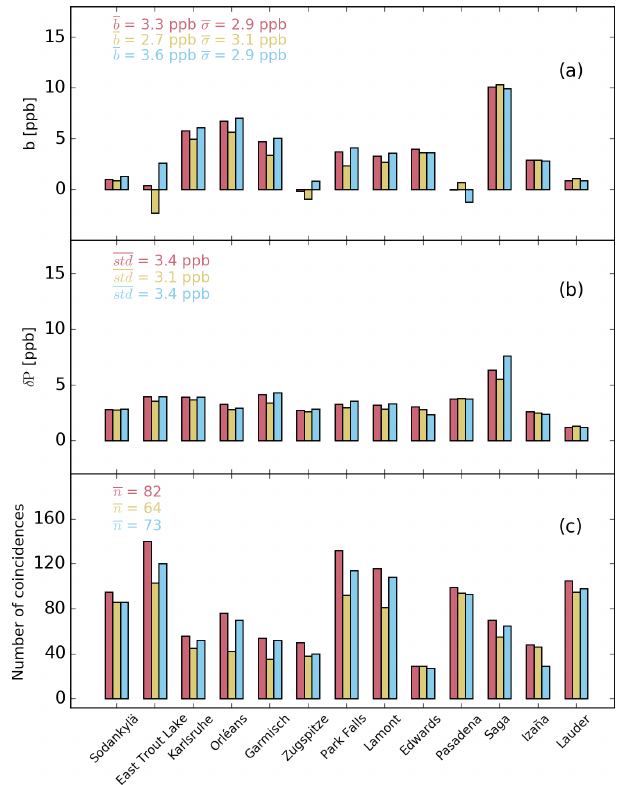
Figure 5. The same as Fig. 3 but comparing TCCON measure- ments with CAMS-IFS CO model data, which are colocated with the TROPOMI observations of Fig. 3. To this end, we interpolated the CAMS-IFS model temporally and spatially to TROPOMI mea- surements and also applied the averaging kernels of TROPOMI on the vertical profiles of the model. In this model comparison a spec- tral fit quality (rms) plot is not needed and is therefore replaced by the number of coincidences.